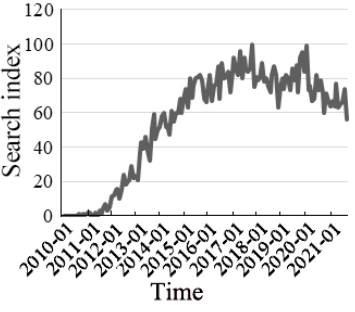
Fig. 5 Trend on Google search queries on big data